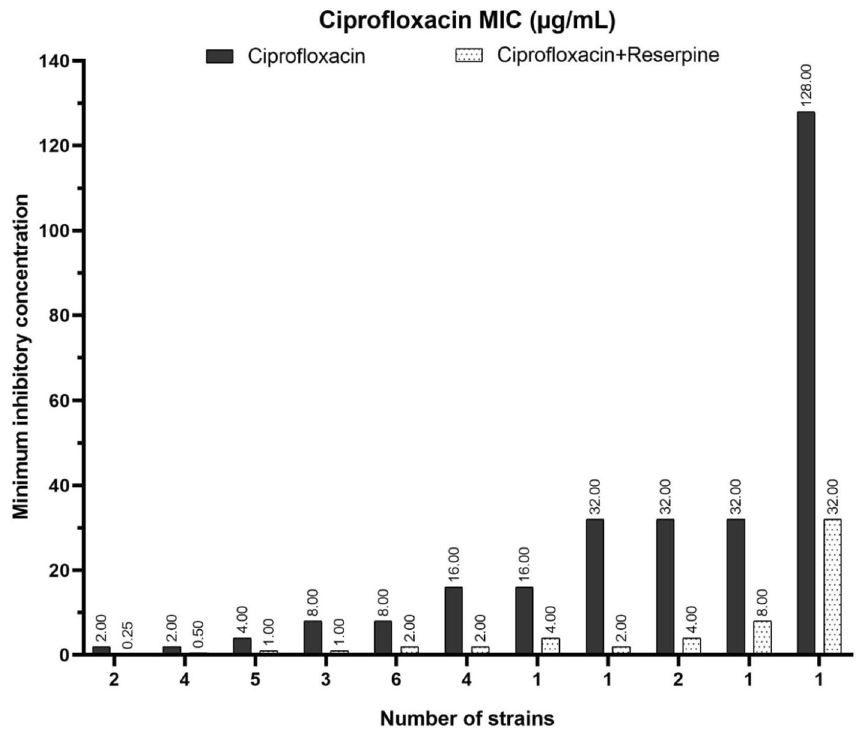
Figure 1. Minimum inhibitory concentrations of ciprofloxacin among the 30 strains of Stenotrophomonas maltophilia before and after the reserpine treatment.